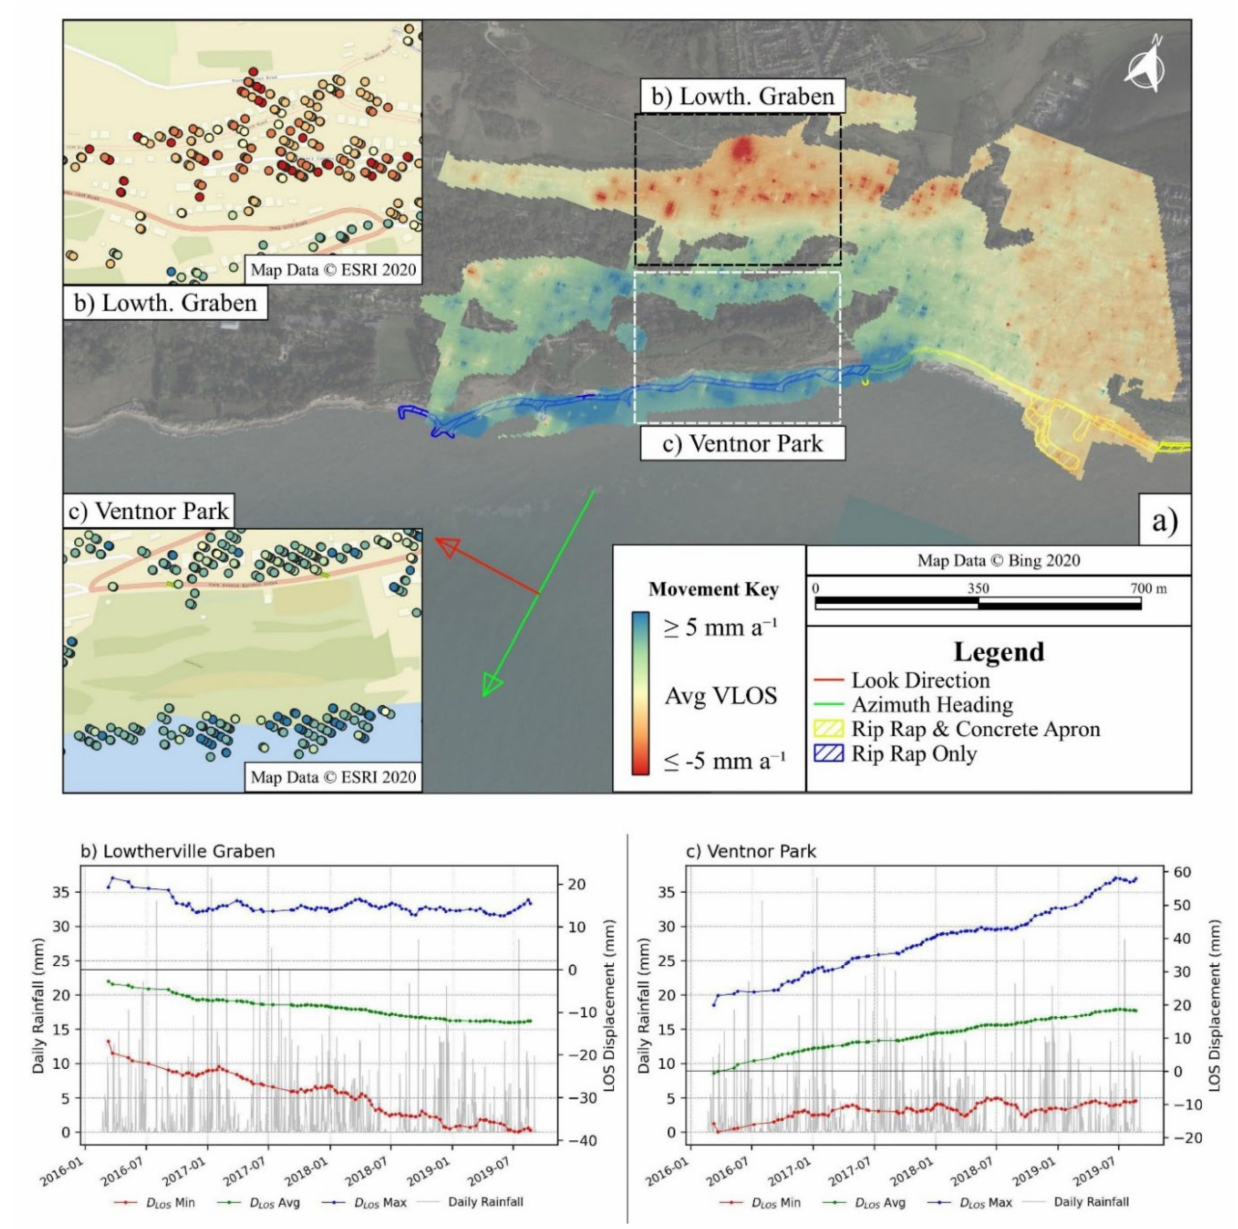
Figure 11. ( a – c ): Aerial view of the Ventnor landslide complex IDW of average velocity in mm a − 1 created from descending data (Track 81) ( a ). Maximum, average and minimum seven scene moving average D LOS for all selected points, shown as insets on ( a ), at the Lowtherville Graben ( b ) and Ventnor Park ( c ). Daily rainfall data from the Ventnor Park rain gauge are also plotted on ( b , c ). Image ( a ) created on QGIS with background imagery from Bing Maps (2020), ( b , c ) using background imagery from the ESRI World Street Map (Service Layer Credits: Esri, DeLorme, HERE, USGS, Intermap, iPC, NRCAN, Esri Japan, METI, Esri China (Hong Kong), Esri (Thailand), MapmyIndia,